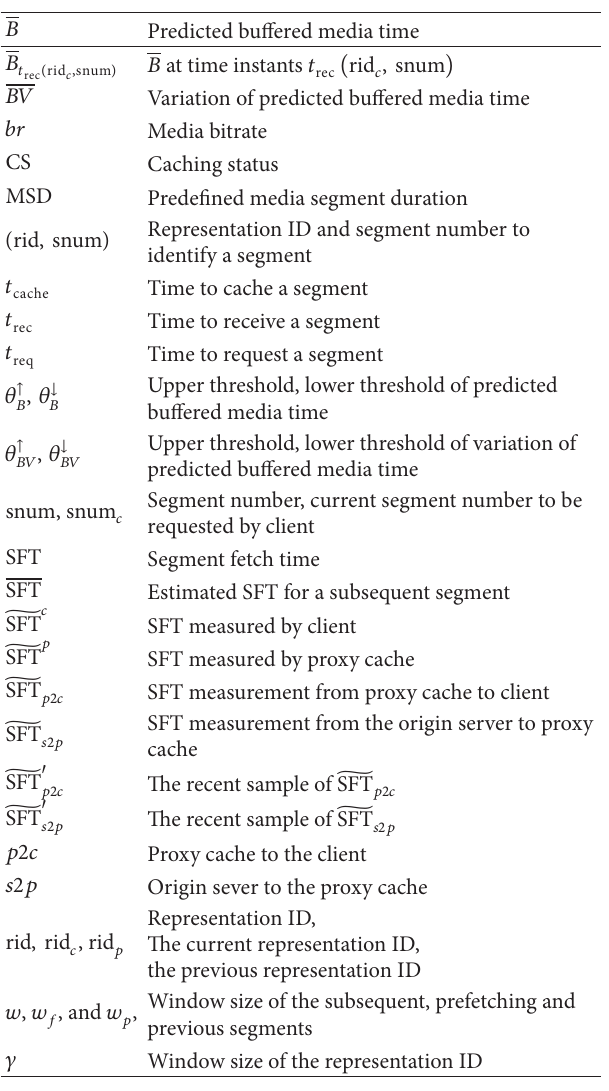
Table 1: Definition of the main